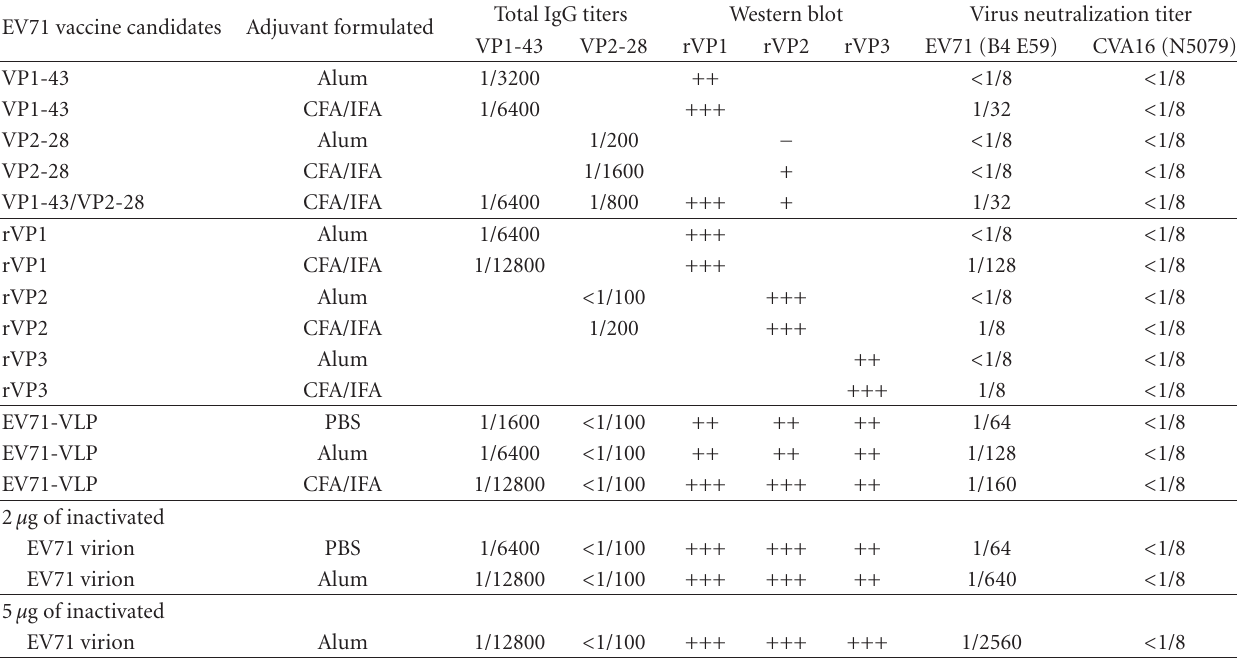
Table 1: Summary of mouse immunogenicity studies with di ff erent EV71 vaccine candidates. EV71 vaccine candidates Adjuvant formulated